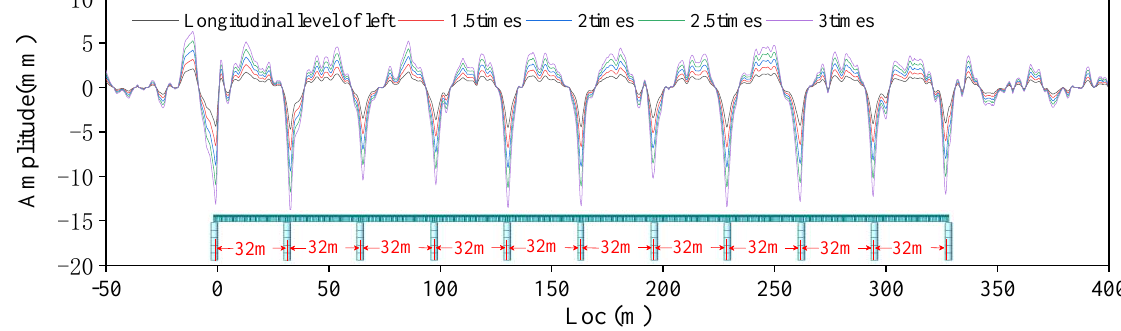
Figure 14. Track longitudinal level and 10-meter chord measurement in bridge section. The amplitude of track longitudinal level, 10-meter chord measurement value, and peak-to-peak value (the difference between the maximum value of the track longitudinal level at the midspan of the beam and the average value of the left and right beam joints for each span) are shown in Table 2. The table shows that when the dynamic longitudinal level at the beam joint is −1 0.30 mm, the corresponding 10-meter chord measurement value reaches −1 0.44 mm, which is close to the level IV (11 mm) of the static-track geomet- ric irregularity allowable deviation management value [17].